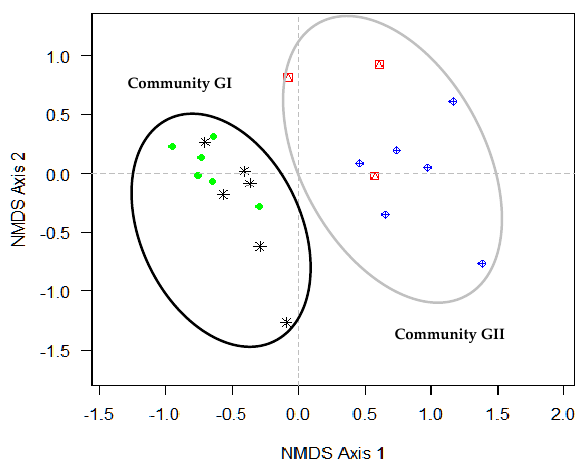
Figure 2. Non-metric multidimensional scaling (NMDS) diagram, showing the grouped plots based on the floristic composition (Stress = 0.12). The circles separate the floristic groups (Communities I–II). The black circle contains the plots installed in the lowest areas of the cone of the Volcano and the gray circle contains the plots sampled in the highest areas of the cone. Table 1. p -Values of variables that significantly influence the formation of floristic groups in the paramo of Sumaco volcano. NMDS: non-metric multidimensional scaling. *** p < 0.001 * p <